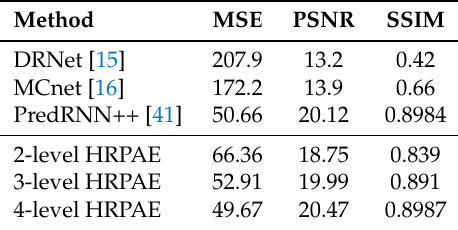
Table 2. Results with the Moving MNIST dataset. The metrics are averaged over 10